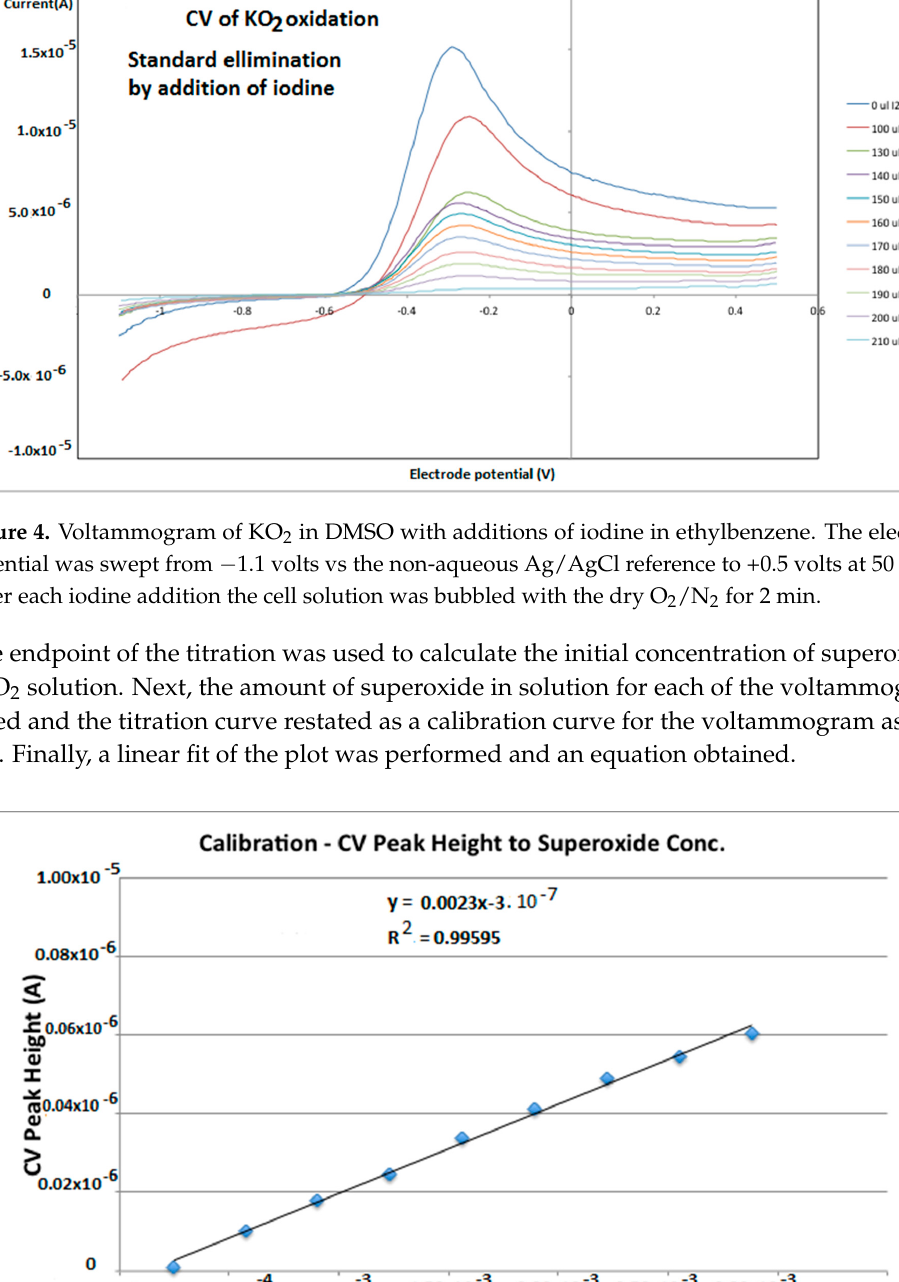
Figure 6. Flavonoids studied.